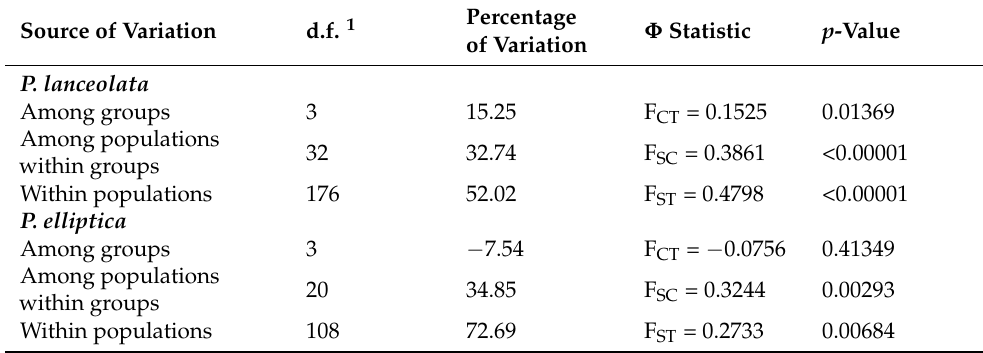
Table 2. Analysis of molecular variance (AMOVA) among populations based on rbc L data.